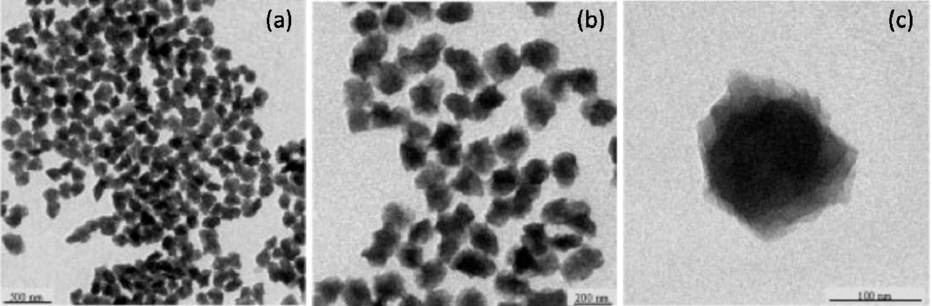
Figure 7. TEM images of PAN-NPs in different scale bar: ( a ) 500 nm ( b ) 200 (nm) ( c ) 100 nm.